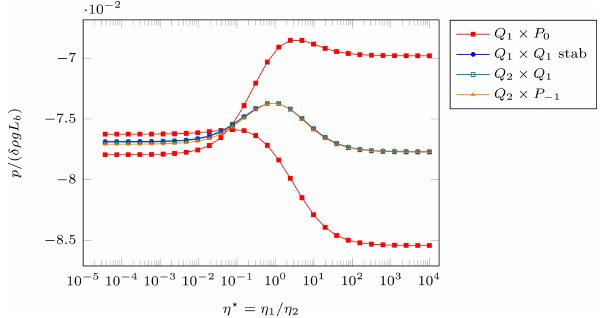
Figure 13. Sinking block benchmark. Normalized pressure p/(δρ gL b ) in the center of the block as a function of the viscosity ratio η (cid:63) . These computations use a 256 × 256 mesh and the reduced density. For the Q 1 × P 0 and Q 2 × P − 1 elements with their discon- tinuous pressure spaces, we show the normalized pressures at sev- eral slightly displaced points (x c ± δx,y c ± δy) . For the Q 2 × P − 1 element, the difference is not visible, but for the Q 1 × P 0 this yields the two very different red curves; this is due to the fact that the pres- sure for this element forms a stairstep function for which two of the evaluation points are on a lower and two on a higher